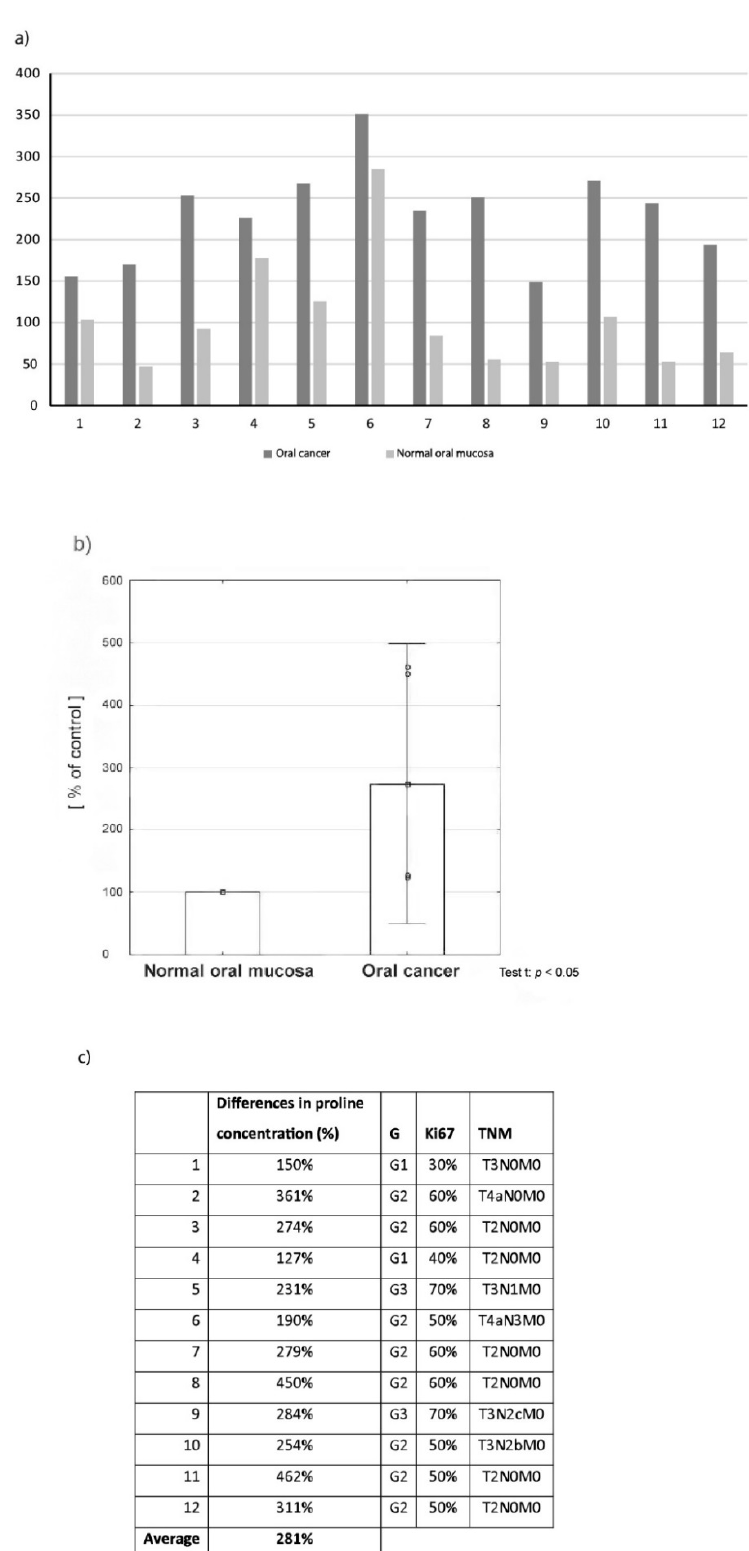
Figure 1. Proline concentration in oral cancer tissue in comparison to normal oral mucosa: ( a ) values presented for individual patients, ( b ) the average value of proline concentration in all cancer tissue in comparison to normal tissue, ( c ) Correlation between proline concentration in tumour tissue and tumour malignancy (histological grade and clinical stage).